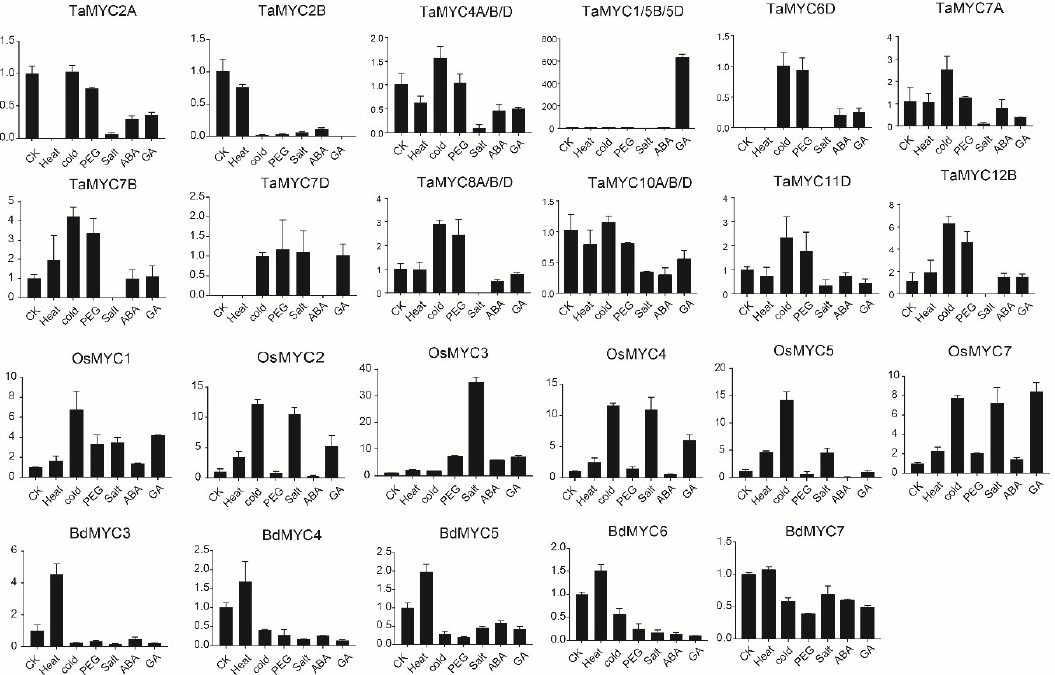
Figure 7. Expression patterns of TaMYC , OsMYC , and BdMYC genes under abiotic stresses; CK (H2O), Heat, Cold, PEG, Salt, ABA, GA indicate different treatments. The horizontal and vertical axes stand for different abiotic stresses and the relative expression, respectively.